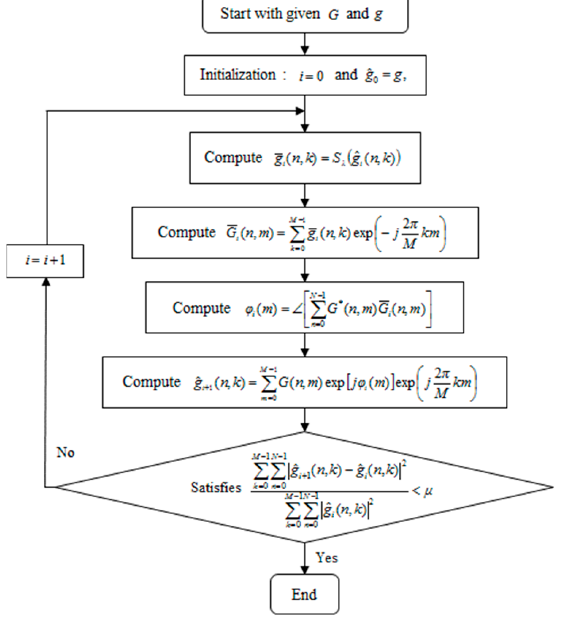
Figure 1. Flowchart of the proposed algorithm.